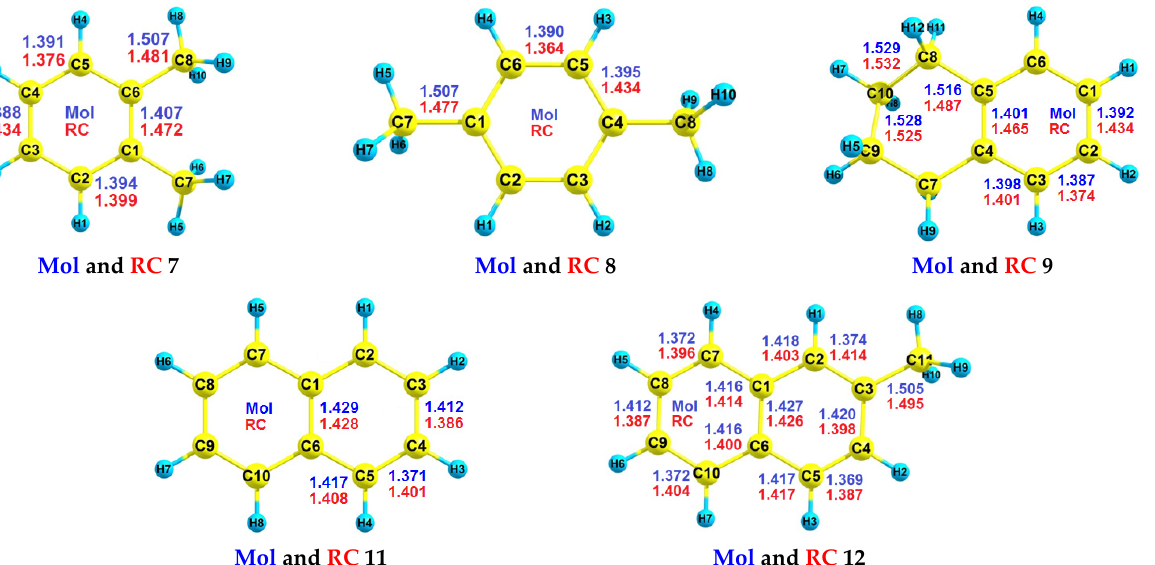
Figure 7. The DFT calculated geometries of RH 7 – 9 , 11 , 12 molecules ( Mol ) and its radical cations